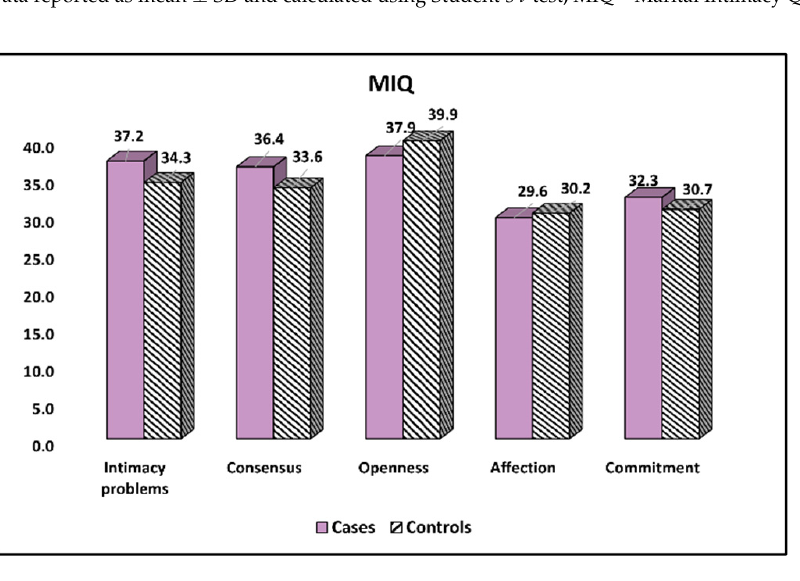
Table 6. Comparison of MIQ survey results between cases and controls.